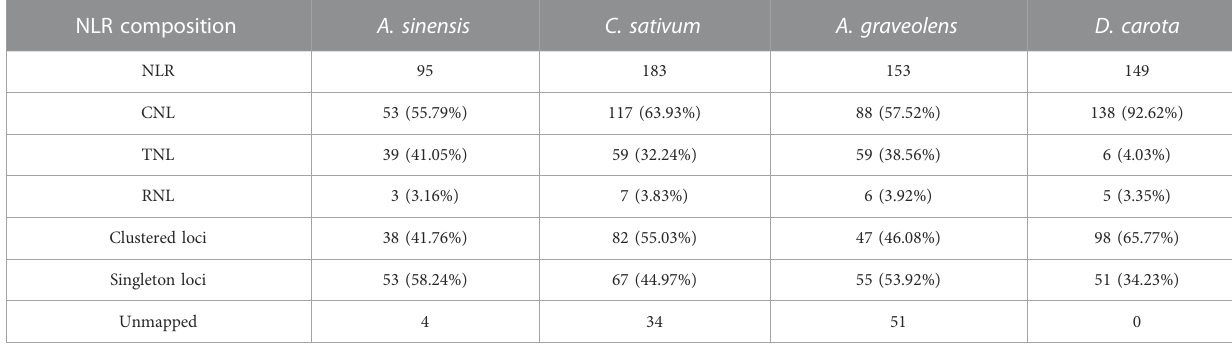
TABLE 2 The number and composition of identi fi ed NLR genes in the studied four Apiaceae species. NLR